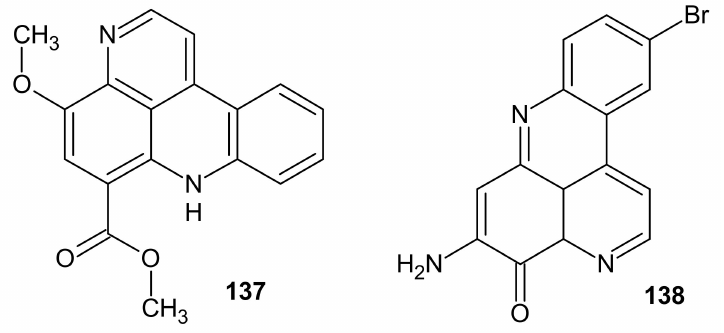
Figure 36. Norsegoline 137 and Pantherinine 138 .